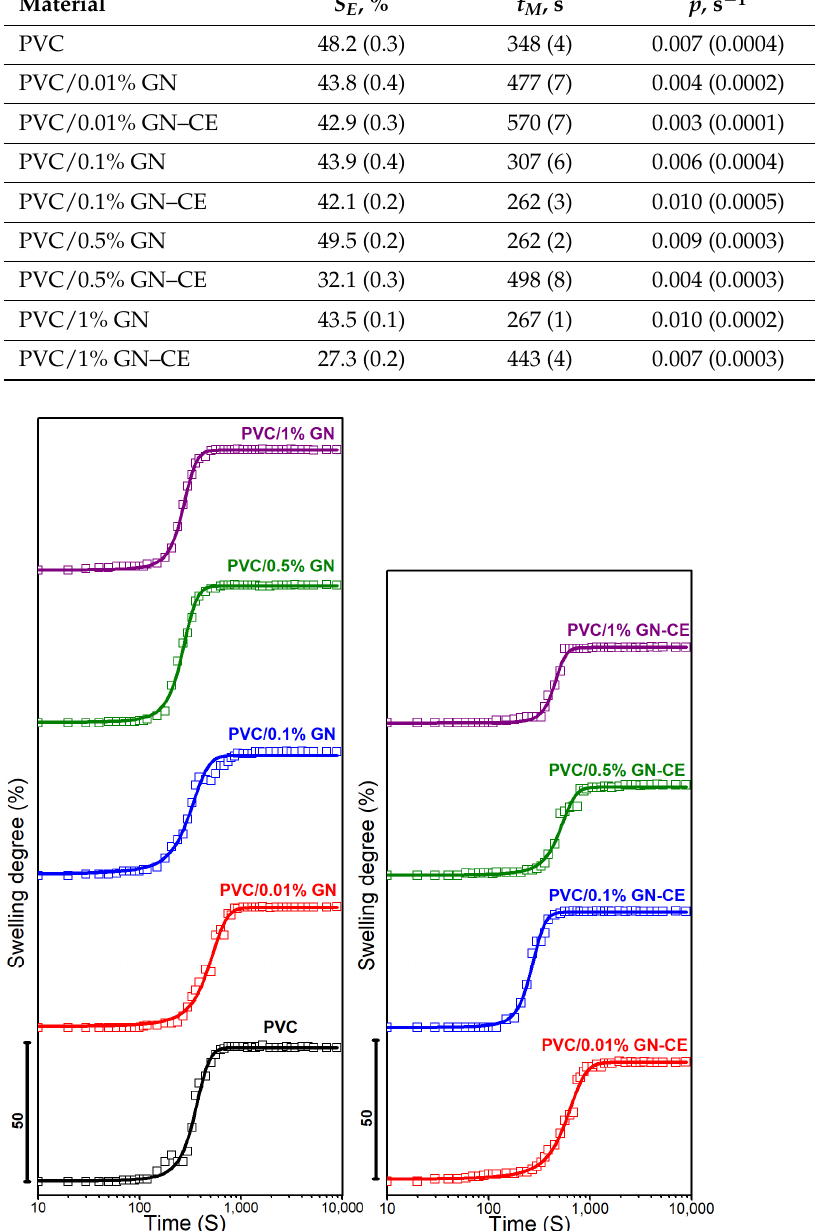
Figure 14. Swelling degree of PVC, PVC/GN and PVC/GN–CE nanocomposites vs. time. PVC/GN nanocomposites were found to have a lower equilibrium swelling ratio compared to unmodified PVC; the lowest SE value observed for PVC/1%GN, i.e., 43.5%, shows an improvement of about 5% in terms of the chemical resistance on the polymer ma- trix. Materials obtained with the addition of extract-modified graphene were characterized by a lower value of SE compared to corresponding materials with unmodified graphene. This effect was attributed to the better dispersion of the filler in the polymer matrix, as evidenced by significantly lower SE values for materials with 0.5 and 1% GN–CE. They were 32.1 and 27.3%, respectively, which represents a reduction in the equilibrium degree of swelling relative to PVC of 14.1%, in the case of PVC/0.5%GN–CE, and of 20.9%, in PVC/1%GN–CE. In addition, it should be noted that the agglomeration of the fi ller in the polymer matrix can lead to lower resistance to solvents in the form of acetone, which was observed in PVC/0.5%GN, where the SE was 1.3% higher relative to PVC. As the GN–CE content of the nanocomposites increases, the time in which the swelling occurs with a maximum rate (t M ) also increases, which further con fi rms the correlation between acetone resistance of the materials and fi ller surface modi fi cations. In materials with unmodi fi ed GN, a decrease in t M values was observed with an increase in its content in the PVC matrix. An increase in the chemical resistance of PVC, by using carbon fi llers, occurs as a result of a decrease in its free volume. Consequently, this leads to a reduced access of solvents to the polymer chain [22,103]. In the case of the materials in question, this mech- anism is very likely, as con fi rmed by the higher resistance of nanocomposites containing GN–CE, characterized by a be tt er dispersion of graphene in the polymer matrix.